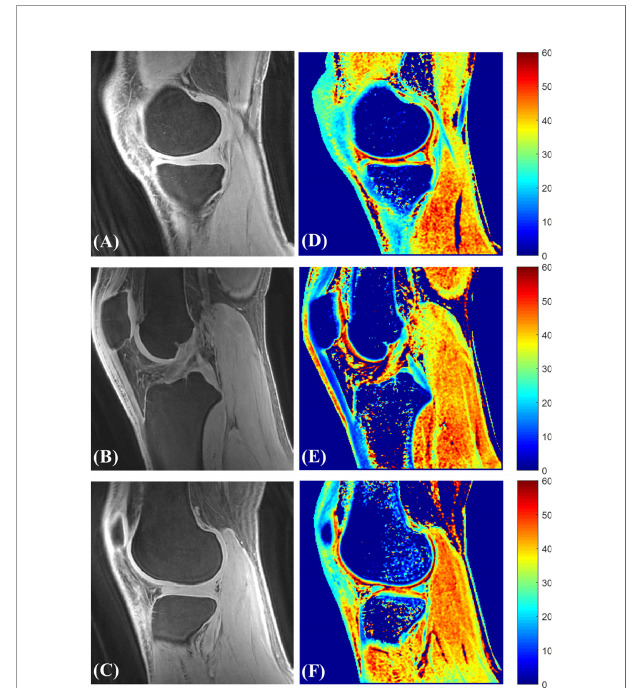
FIGURE 14 | Representative 3D UTE-AdiabT 1 r Cones images (A – C) with their corresponding T 1 r maps (D – F) .